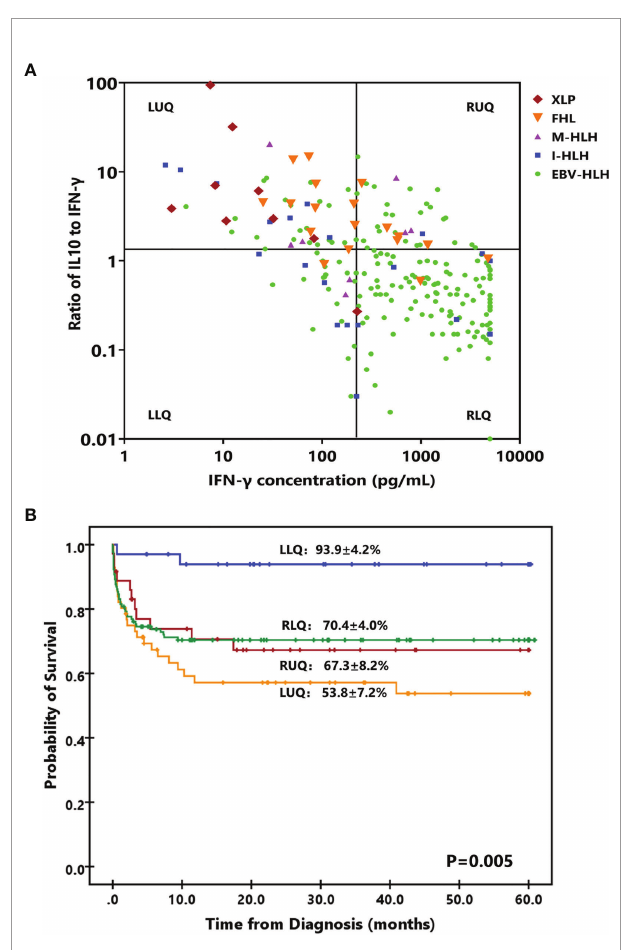
FIGURE 3 | A four-quadrant model to differentiate HLH patients with different features. (A) Distribution of patients with EBV-HLH, I-HLH, M-HLH, FHL, and XLP in a four-quadrant diagram based on the ratio of IL-10 to IFN- g (> 1.33 or ≤ 1.33) and the IFN- g level (> 225 pg/ml or ≤ 225 pg/ml). (B) Kaplan – Meier survival curves for 5-year overall survival (OS) of the patients located in four quadrants. I-HLH, infection-associated HLH triggered by pathogens other than EBV; M-HLH, malignancy-associated HLH; FHL, familial HLH; XLP, X- linked lymphoproliferative disease; LLR, left lower quadrant; LUR, left upper quadrant; RUQ, right upper quadrant; RLQ, right lower